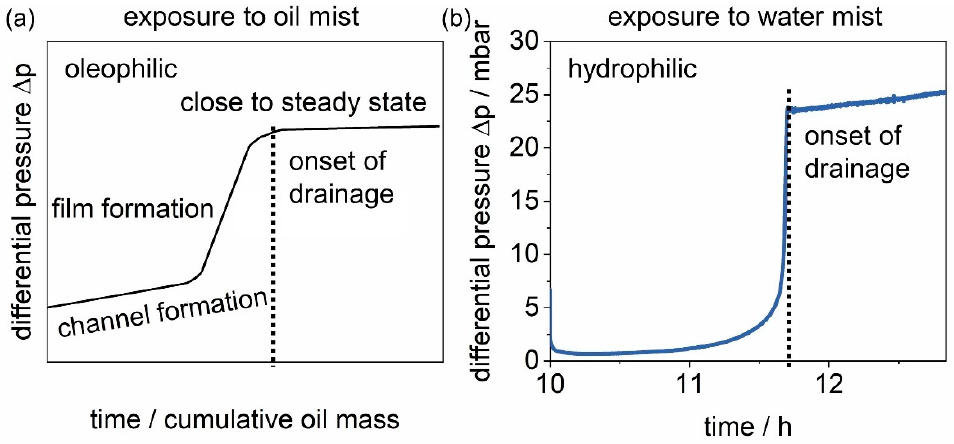
Figure 10. Comparison of ( a ) the schematic differential pressure for oleophilic filter media described by the jump-and-channel model and ( b ) the observed behavior during exposure to water mist of a salt-laden filter (compare Figure 3).